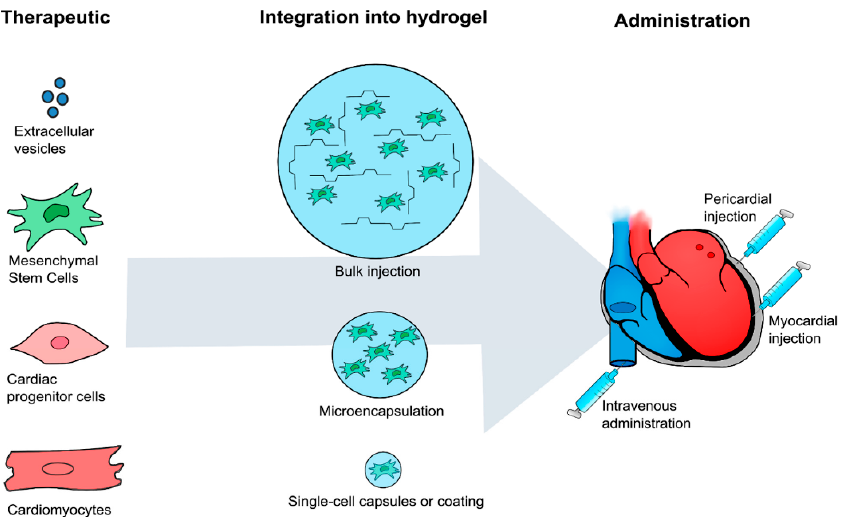
Figure 5. Strategies for cardiac diseases using injectable hydrogels. The therapeutics have been in- tegrated into hydrogels and delivered by bulk injection, microencapsulation, and single-cell cap- sules/coating. Combinational therapy has primarily been administered through intramyocardial in- jections, but intravenous and pericardial injections have also been reported (reprinted with permis- sion from